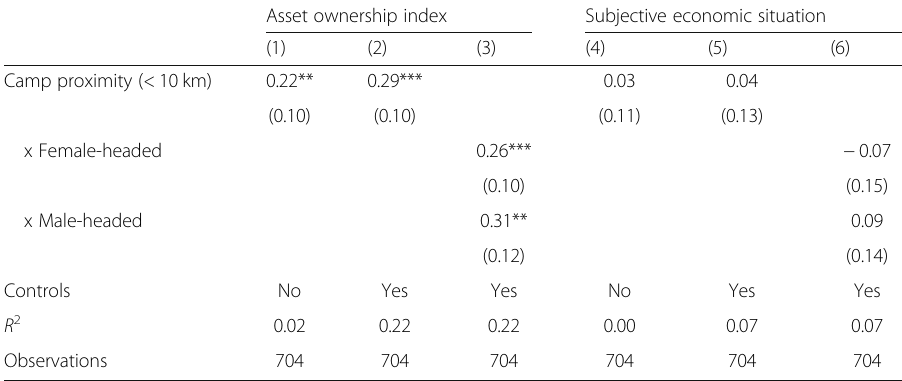
Table 14 Limited sample, economic welfare Asset ownership index